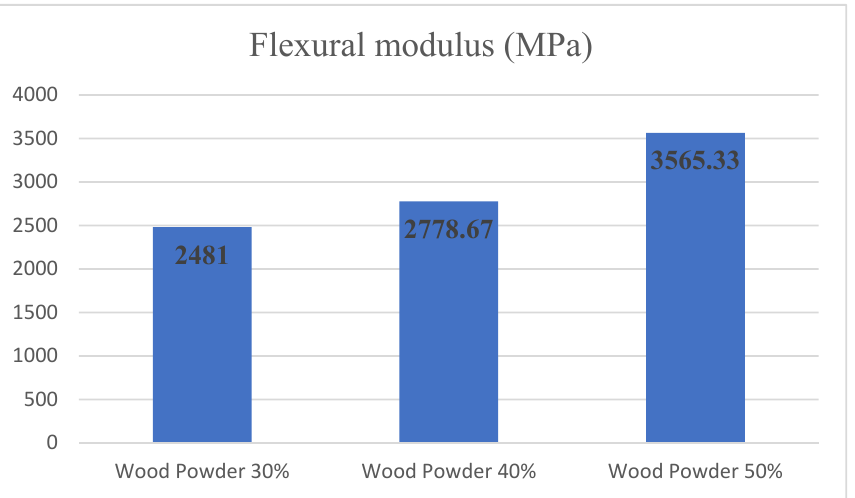
Figure 7. Flexural modulus comparison according to a different amount of wood powder and 0% nanoclay.